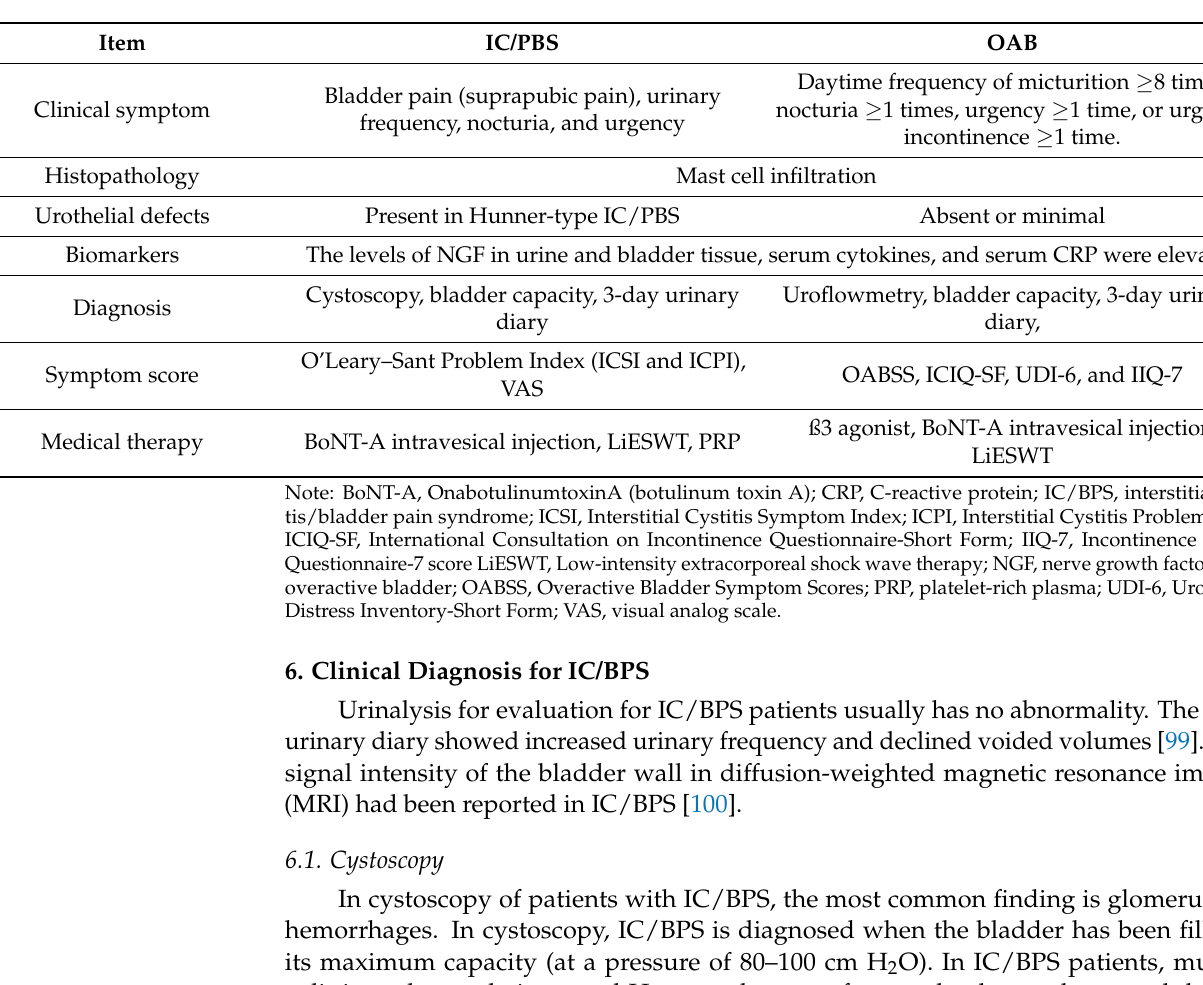
Table 2. Clinical symptom, histopathology, biomarkers, diagnosis, and treatment exhibit differences between IC/PBS and